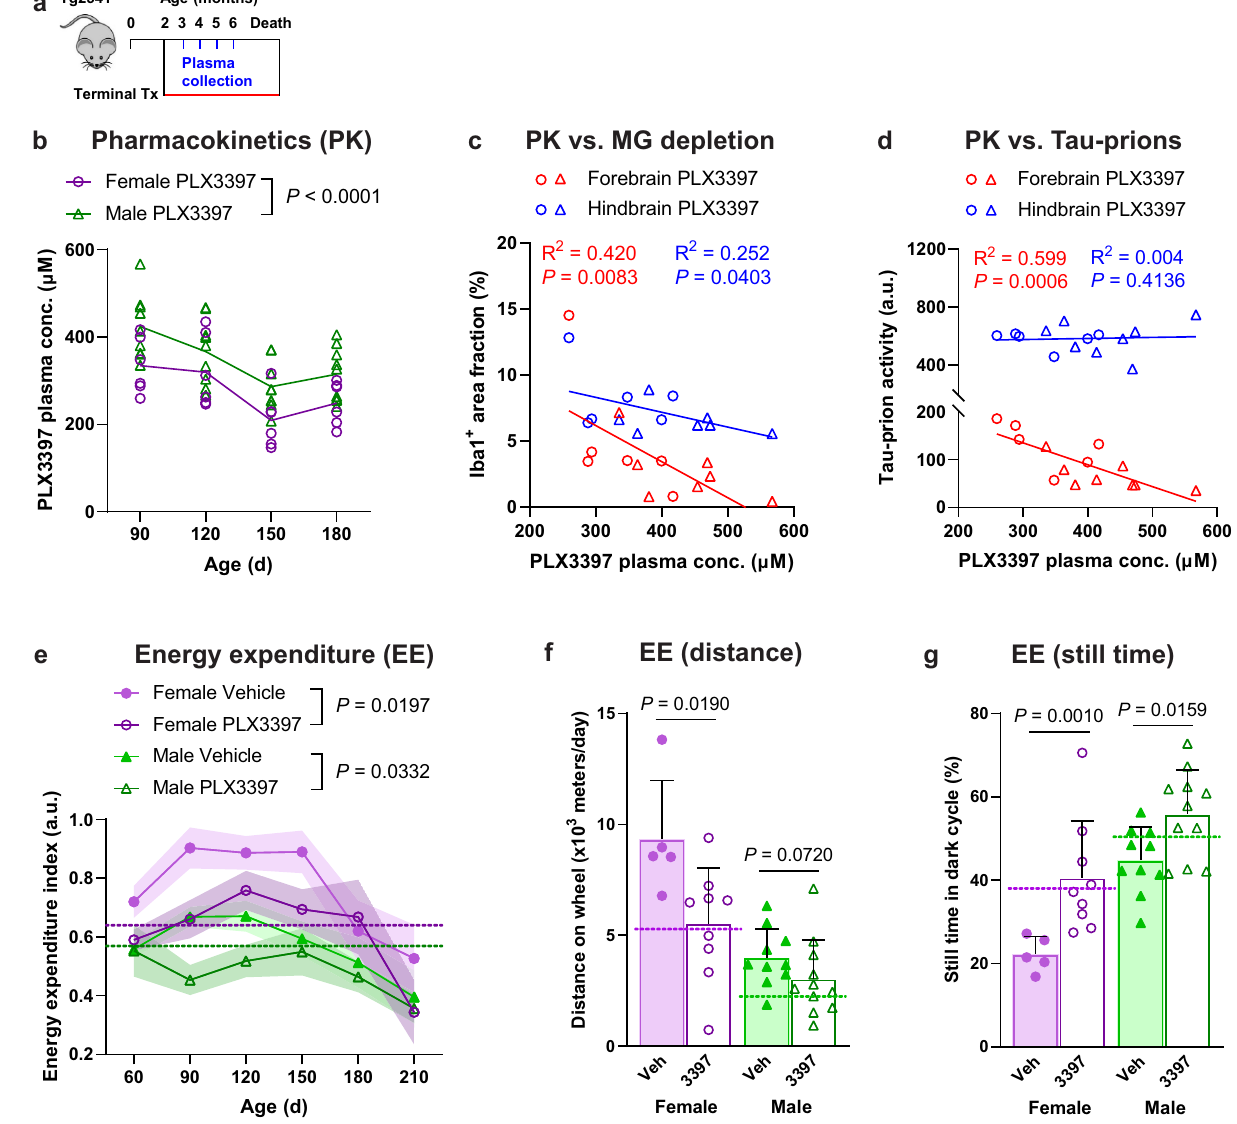
Fig. 3 | PLX3397 has sex-dependent pharmacokinetics and reduces hyper- activity of Tg2541 mice. a Schematic of terminal PLX3397 treatment (275mg/kg oral)of Tg2541micefrom 2 mo of ageuntil death and blood plasma collected at3, 4,5,and6moof age. b PlasmaconcentrationofPLX3397infemaleormaleTg2541 mice. Each symbol represents an individual mouse and the lines indicate group means. The difference between female and male mice was assessed by two-way repeated measures ANOVA. c , d Correlation plots for plasma concentration of PLX3397at90dageandIba1areafractionbyIHC( c )ortau-prionactivity( d )inthe forebrains or hindbrains of Tg2541 mice at death. Female mice are shown as open circles and male mice shown as open triangles. Linear regression was performed with female and male mice combined and best- fi t lines are shown. Pearson ’ s cor- relation analysis was performed and the results are shown. e Longitudinal energy expenditure indices (see “ Methods ” ) of female or male Tg2541 mice treated with vehicle or PLX3397. Symbols represent the group means and shaded regions